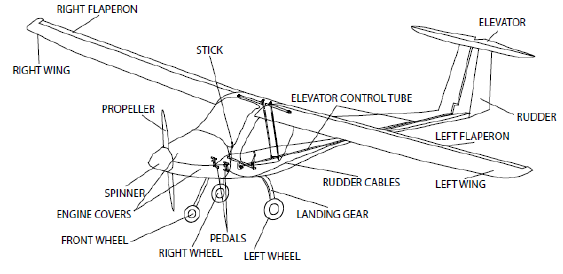
Fig. 2. Alpha Electro construction schema [7]